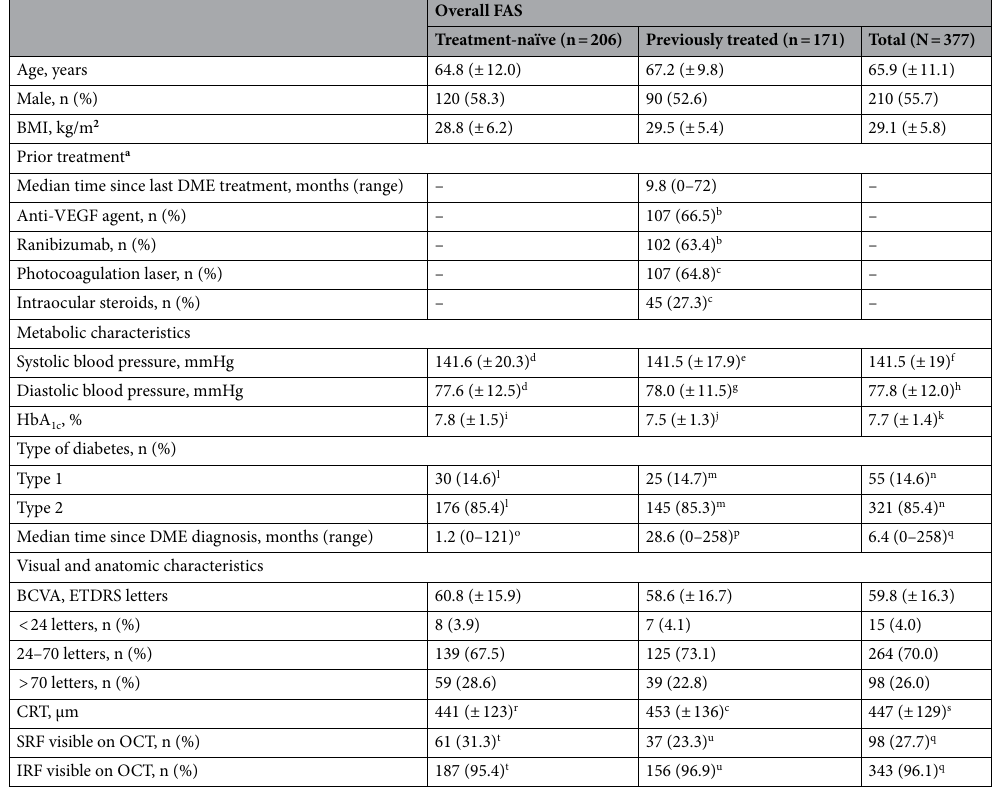
Table 1. Demographics and baseline characteristics of patients in the full analysis set. BCVA best-corrected visual acuity; BMI body mass index; CRT central retinal thickness; DME diabetic macular edema; ETDRS Early Treatment Diabetic Retinopathy Study; FAS full analysis set; HbA 1c , glycated hemoglobin; IRF intraretinal fluid; OCT optical coherence tomography; SRF subretinal fluid; VEGF vascular endothelial growth factor. Values are mean (± standard deviation) unless otherwise stated. a Patients may have received more than one previous treatment for DME. b n = 161; c n = 165; d n = 83; e n = 76; f n = 159; g n = 74; h n = 157; i n = 124; j n = 100; k n = 224; l n = 206; m n = 170; n n = 376; o n = 204; p n = 167; q n = 371; r n = 197; s n = 362; t n = 202; u n =